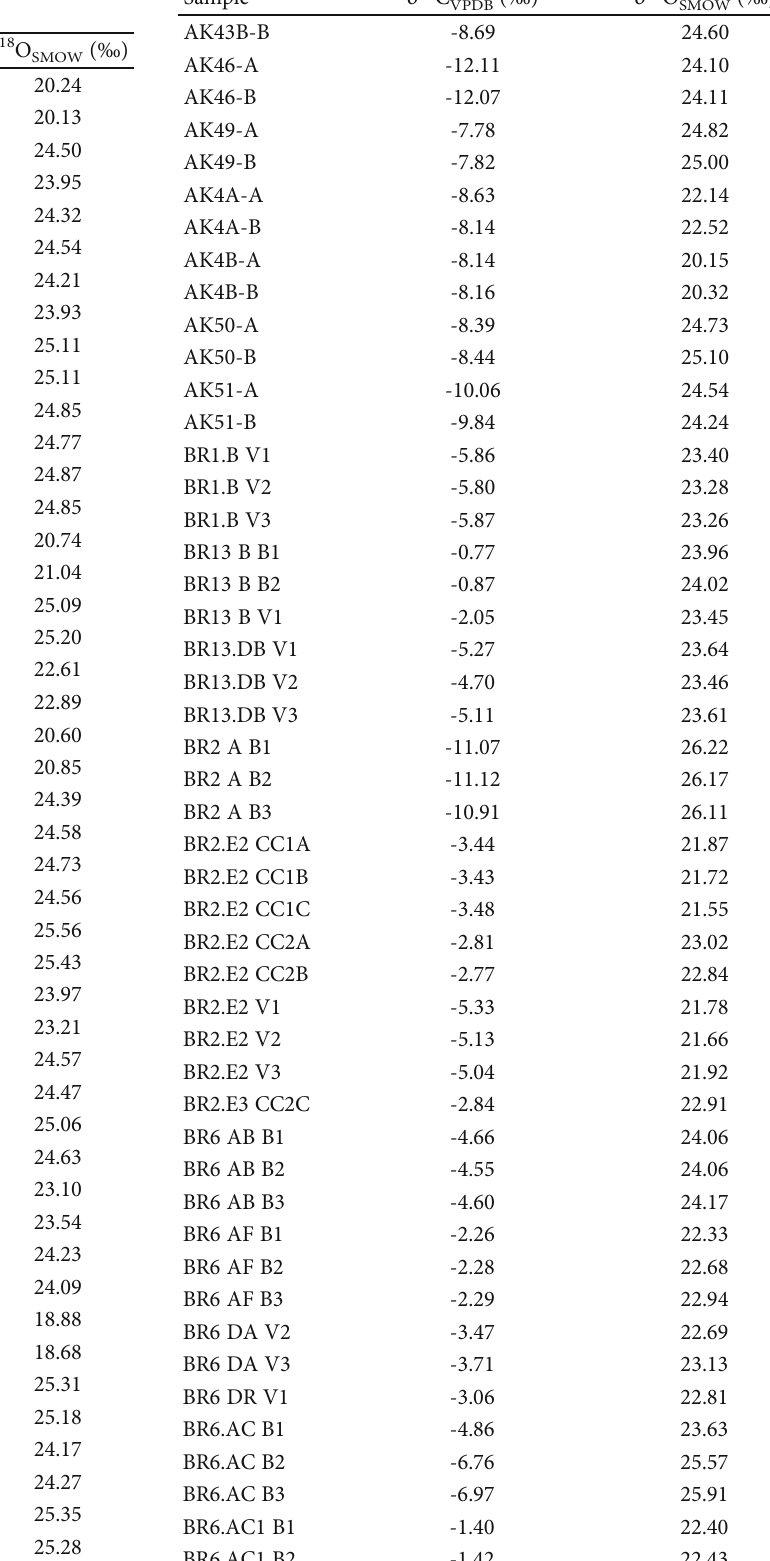
‰ and δ 18 O ‰ stable isotope VPDB SMOW